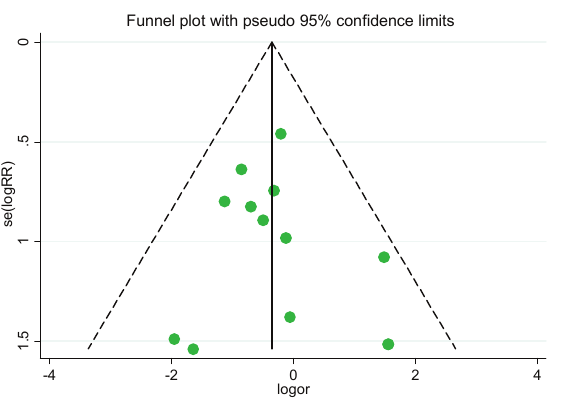
Figure 7: The Begg’s funnel plot for side effects of piribedil in adju- vant treatment of Parkinson’s